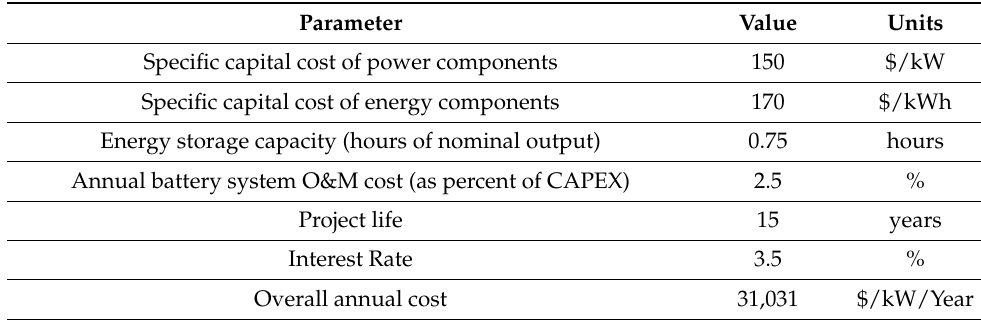
Table 4. Annual cost calculation for 0.75 h BESS.